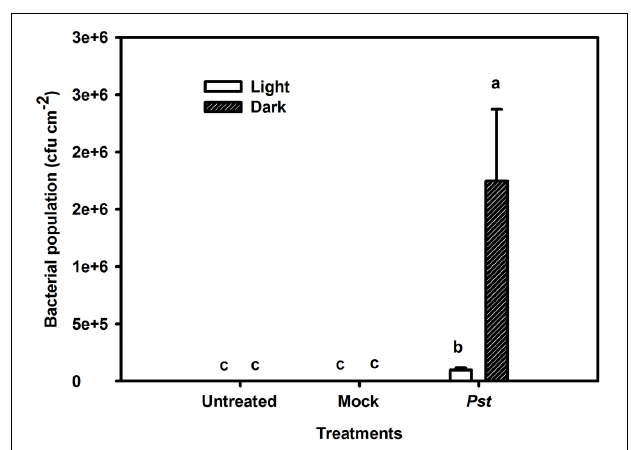
FIGURE 3 | Relative changes in the bacterial population after Pst infection in tobacco leaves. Bacterial population was evaluated after leaves were inoculated with distilled water (Mock) or Pst at 3 dpi under light or dark conditions. Means ± SE of six replicates are presented. Different letters above the columns indicate significant differences between treatments at P <